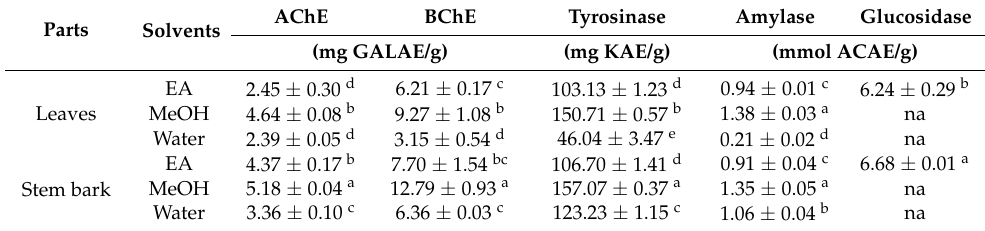
Table 4. Enzyme inhibitory properties of the tested